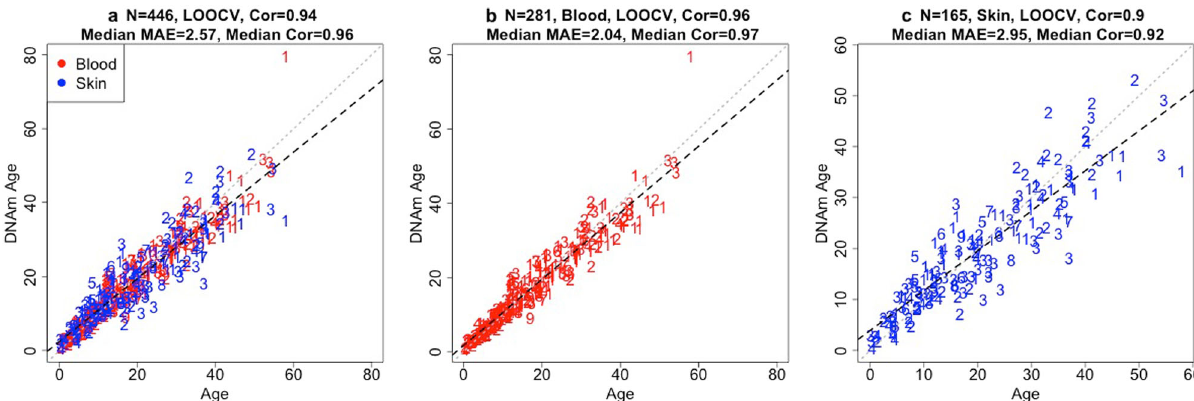
Fig. 1 Cross-validation study of the epigenetic clock for odontocetes. Each dot corresponds to a tissue sample from odontocetes. Dots are colored by tissue type (red = blood, blue = skin) and labeled by species: 1 = bottlenose dolphin ( Tursiops truncatus ); 2 = beluga ( Delphinapterus leucas ); 3 = killer whale ( Orcinus orca ); 4 = Paci fi c white-sided dolphin ( Lagenorhynchus obliquidens ); 5 = short- fi nned pilot whales ( Globicephala macrorhynchus ); 6 = rough-toothed dolphin ( Steno bredanensis ); 7 = Commerson ’ s dolphin ( Cephalorhynchus commersonii ); 8 = common dolphin ( Delphinus delphis ); 9 = harbor porpoise ( Phocoena phocoena ). a – c represent cross validations of different tissue strata, with blood and skin combined ( a ), blood only ( b ), and skin only ( c ). LOOCV corresponds to leave-one-sample out cross validation (LOOCV) estimates. Each panel depicts a linear regression line (black dashed line), a diagonal line (y = x), the sample size ( N ), Pearson correlation (Cor) across all samples, median age correlation across species, and median value of the median absolute error (MAE) across